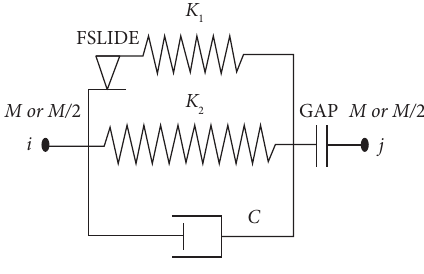
Figure 3: Bilinear damping spring unit.